Question: In a single sentence, describe what this figure presents.
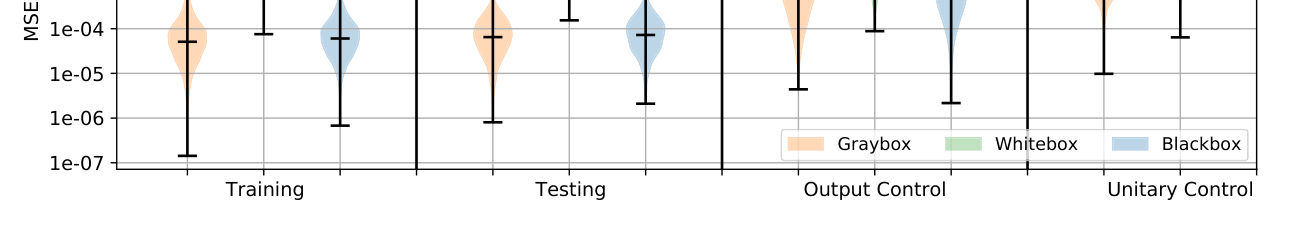
Answer: Experimental quantum control performance. The distribution of the fidelity between the experimentally measured output power distribution and the desired target distribution for the three models. The whitebox model utilizes a real-valued tri-diagonal Hamiltonian with linear dependence on voltages, in addition to fan-in and fan-out sections. The results are for (a) the output controller, and (b) the unitary controller. The reported values are the average over the three distributions corresponding to each possible initial state. (c) Violin plot showing the statistics of the MSE obtained for the training, testing, and control datasets. The horizontal lines represent from bottom to top, the minimum, median, and maximum respectively. The plot also shows an estimated kernel density for the data.